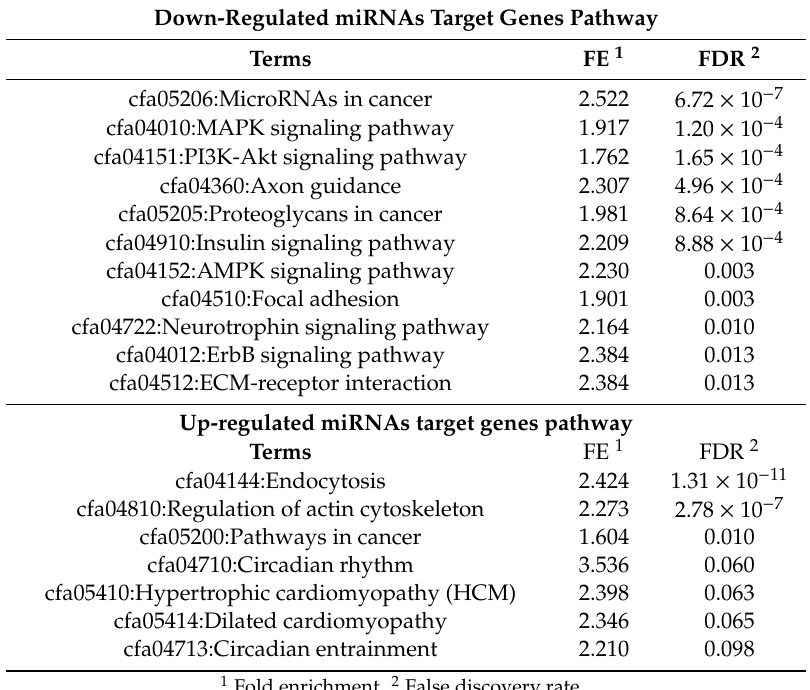
Table 2. KEGG pathway analysis of the target genes of the di ff erentially expressed